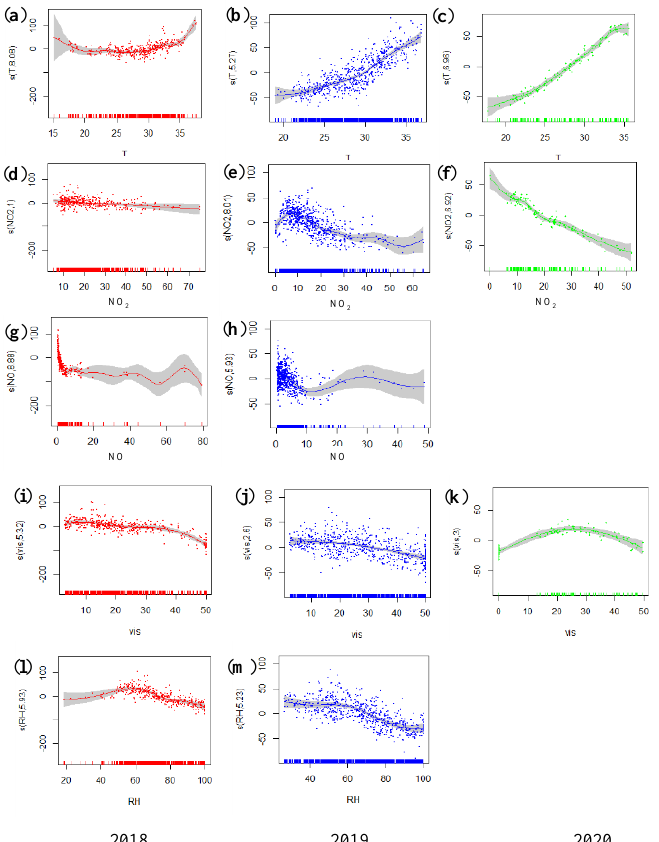
Figure 6. Response curves of O 3 concentration to changes in temperature in 2018 ( a ), 2019 ( b ), 2020 ( c ), NO 2 concentration in 2018 ( d ), 2019 ( e ), 2020 ( f ), NO concentration in 2018 ( g ), 2019 ( h ), vis in 2018 ( i ), 2019 ( j ), 2020 ( h ) and RH in 2018 ( l ), 2019 ( m ), 2020 ( k ). The y-axis represents the smoothing function values; for example, s (T) shows the trend in O 3 concentration when air temperature changes, and df is the degree of freedom for the trend. The x-axis represents the measured values of the influencing factor, the solid curve indicates the trend in O 3 concentration with the change of influencing factors, and the shaded area that is centered around the solid line indicates the CI (lower and upper limits) of O 3 concentration.